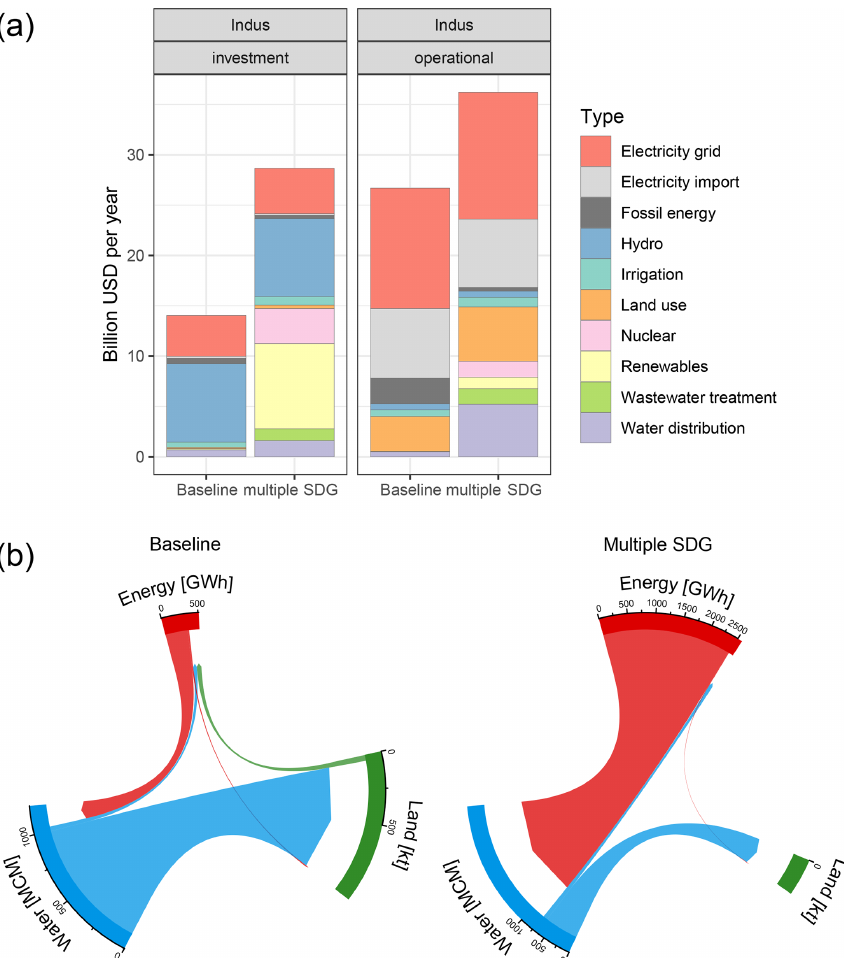
Figure 11. (a) Comparison of investment and operational cost (yearly average) for the entire basin. (b) Representation of water for energy (excluding hydropower) and irrigation (MCM), energy for water management technologies and for agriculture (GWh) and biomass used for energy production